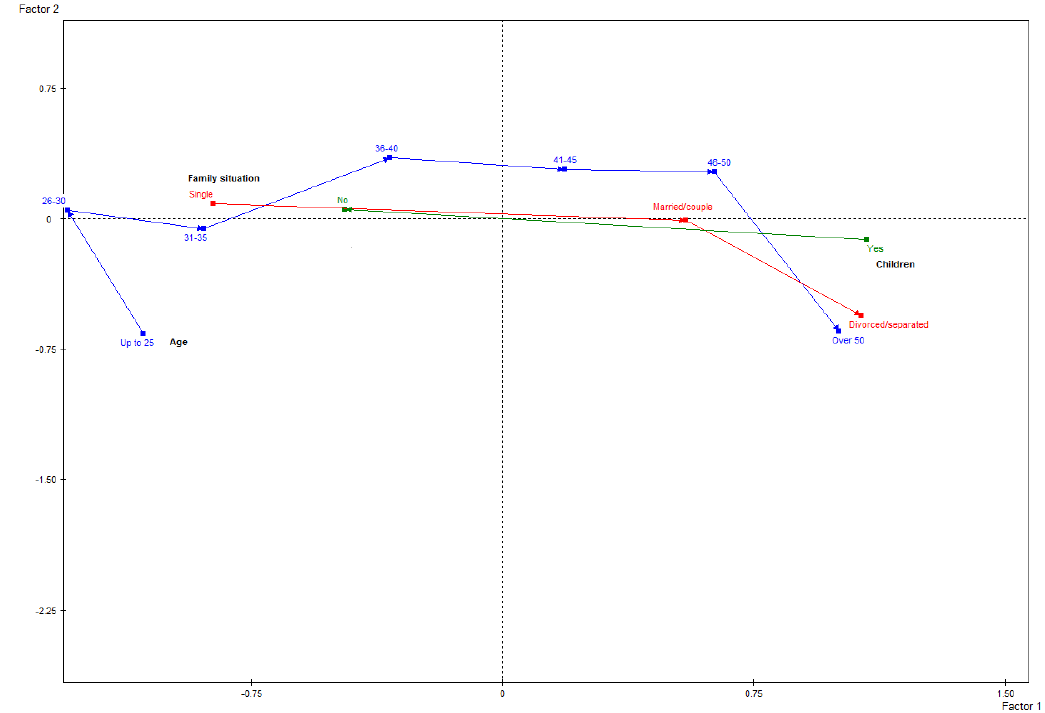
Figure 1. Projection of the variables and modalities that contribute most to factor 1. As regards the interpretation of the second factor, Table 3 shows that the modalities referring to the students’ social background were the most relevant. Both the family educational level and the family occupational level have modalities that contributed more than 50% of the total to this second factor. Contributing less, but still relevant, the modalities referring to the students’ previous educational level contributed about 16% to the second